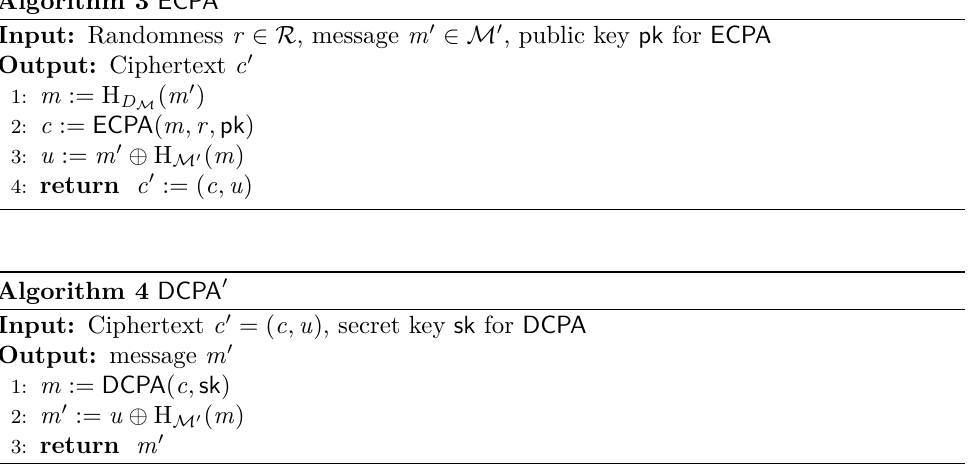
Algorithm 3 ECPA 0